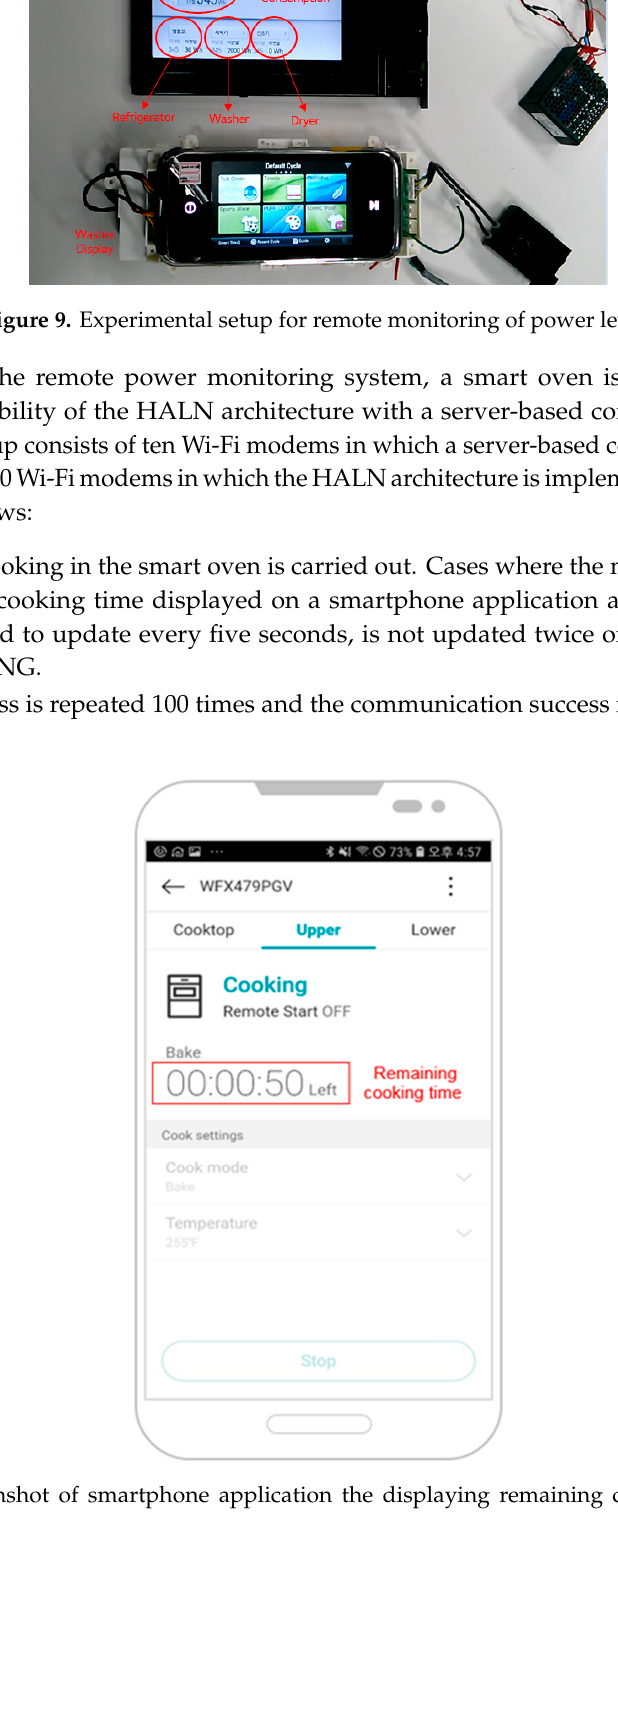
Figure 8. Wi-Fi modem and its specification used for experiments.